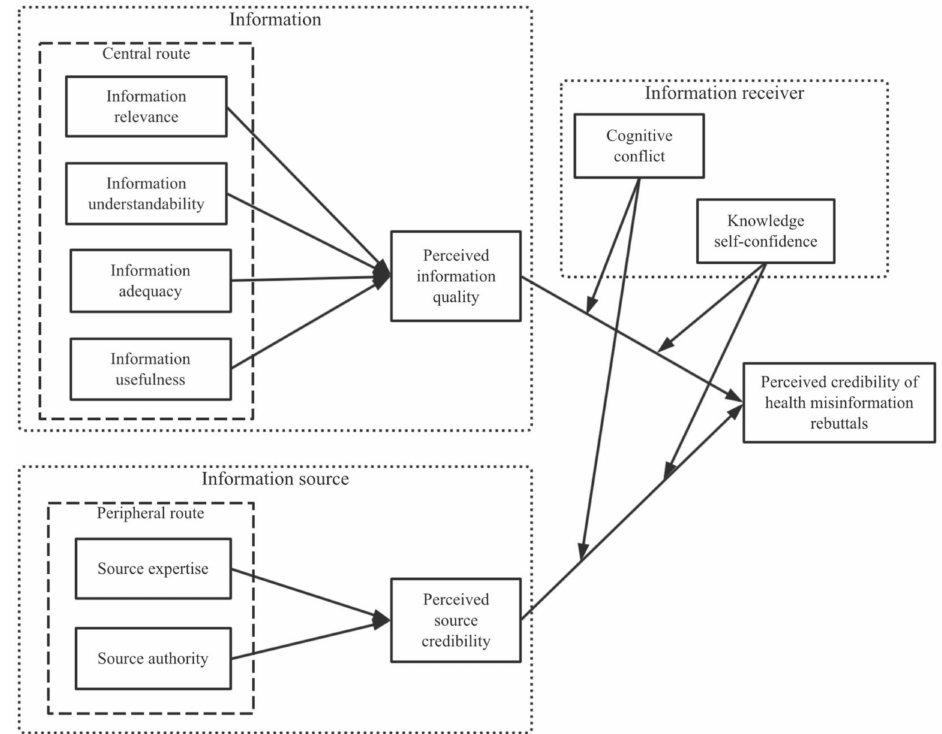
Figure 1. Research